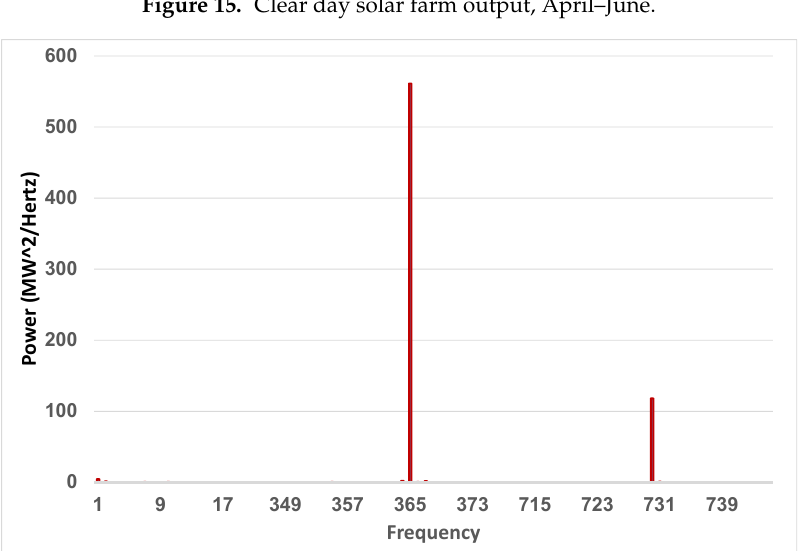
Figure 16. Solar farm output power